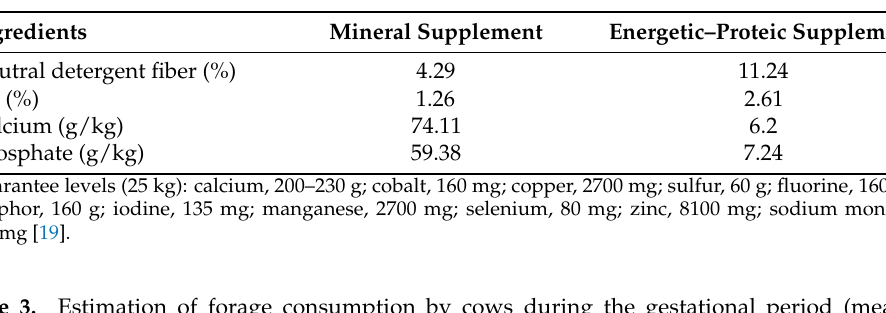
Table 3. Estimation of forage consumption by cows during the gestational period (mean ± standard deviation).